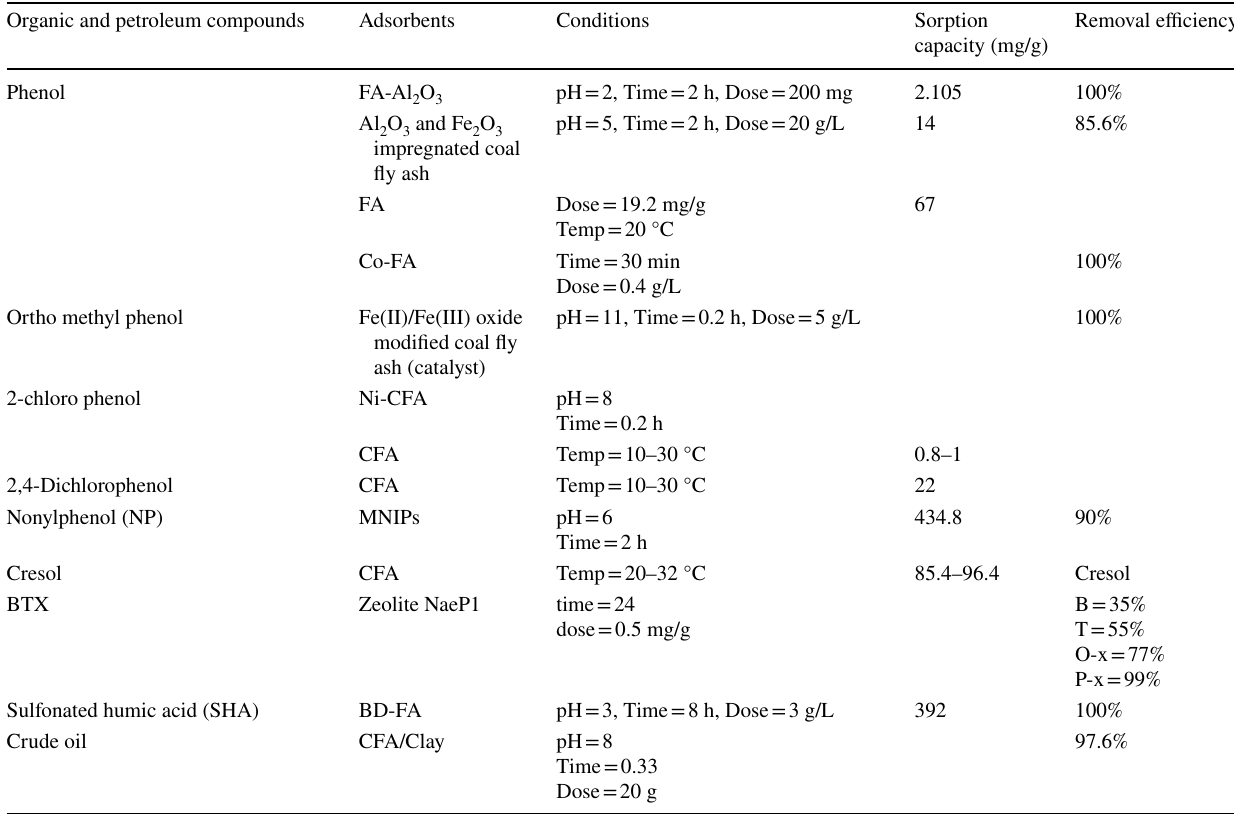
Table 4 Organic pollutant adsorption on fly ash (Wang and Wu 2006; Asl et al. 2019) Organic and petroleum compounds